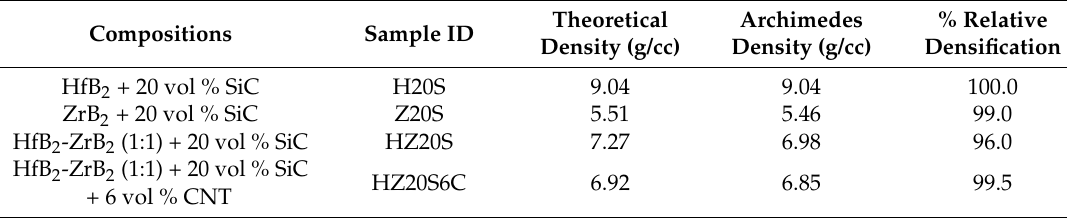
Figure 2. Instantaneous relative density plot of HfB 2 -ZrB 2 -SiC-CNT composites. Table 1. Nomenclature, relative densification and grain size of HfB 2 -ZrB 2 -SiC-CNT composites.